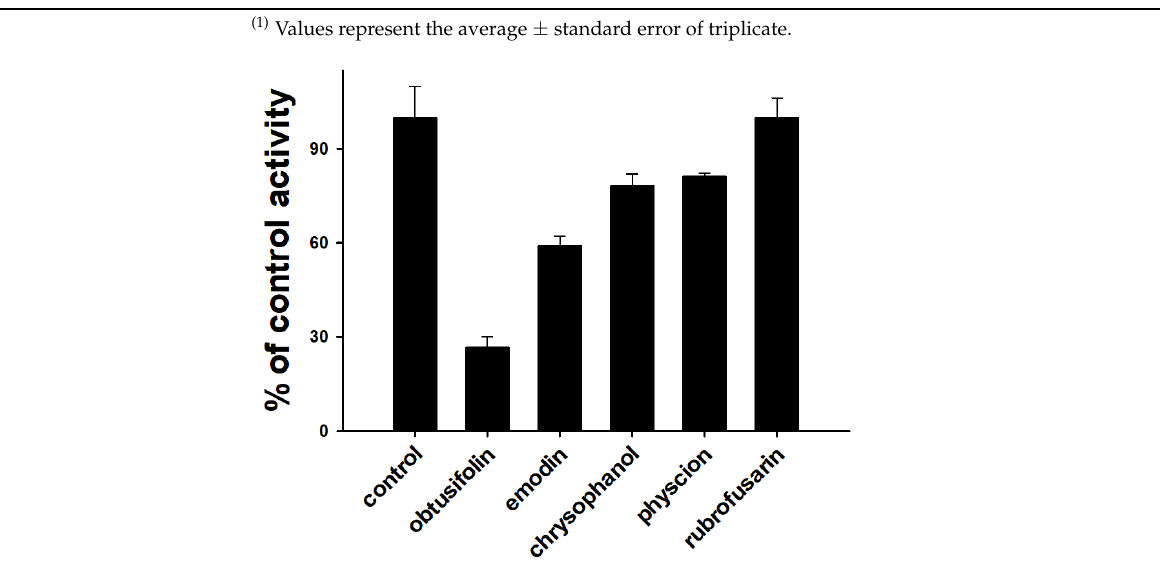
Figure 2. Inhibitory effects of obtusifolin, emodin, chrysophanol, physcion, and rubrofusarin on CYP1A2-mediated phenacetin O-deethylation in human liver microsomes. Pooled human liver microsomes (0.25 mg/mL) were incubated with phenacetin (100 µM) in the presence or absence of each chemical (0.5 µM) at 37 °C for 15 min. The activity is expressed as the percentage of the control activity. The data are depicted as the average obtained from triplicate experiments ( n = 3).